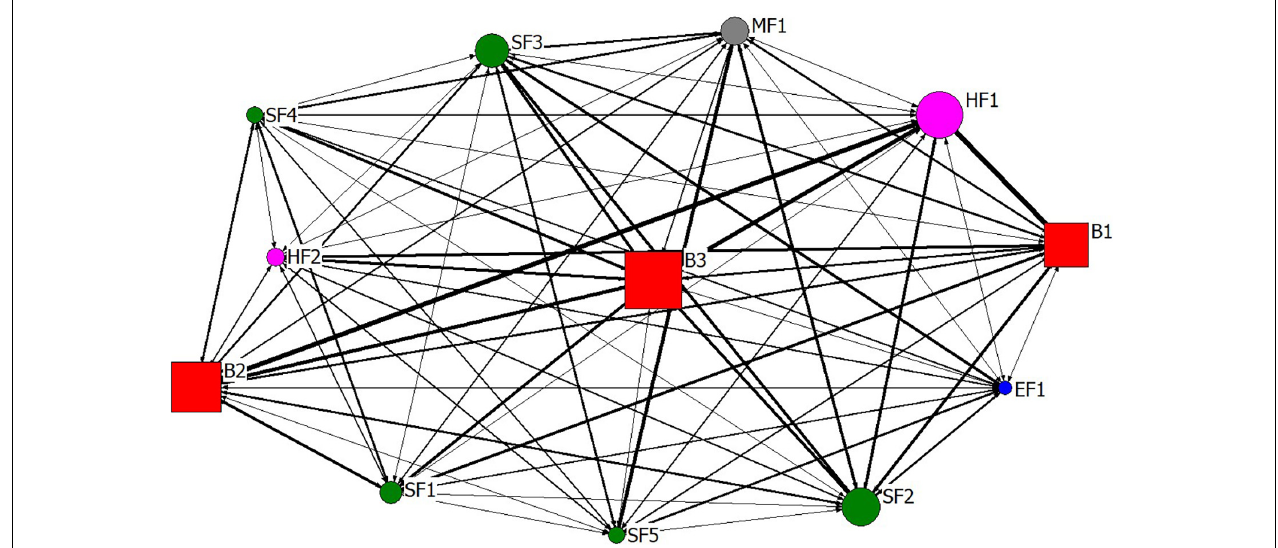
FIGURE 4 | Co-occurrence network of construction workers’ unsafe behavior and its influencing factors.